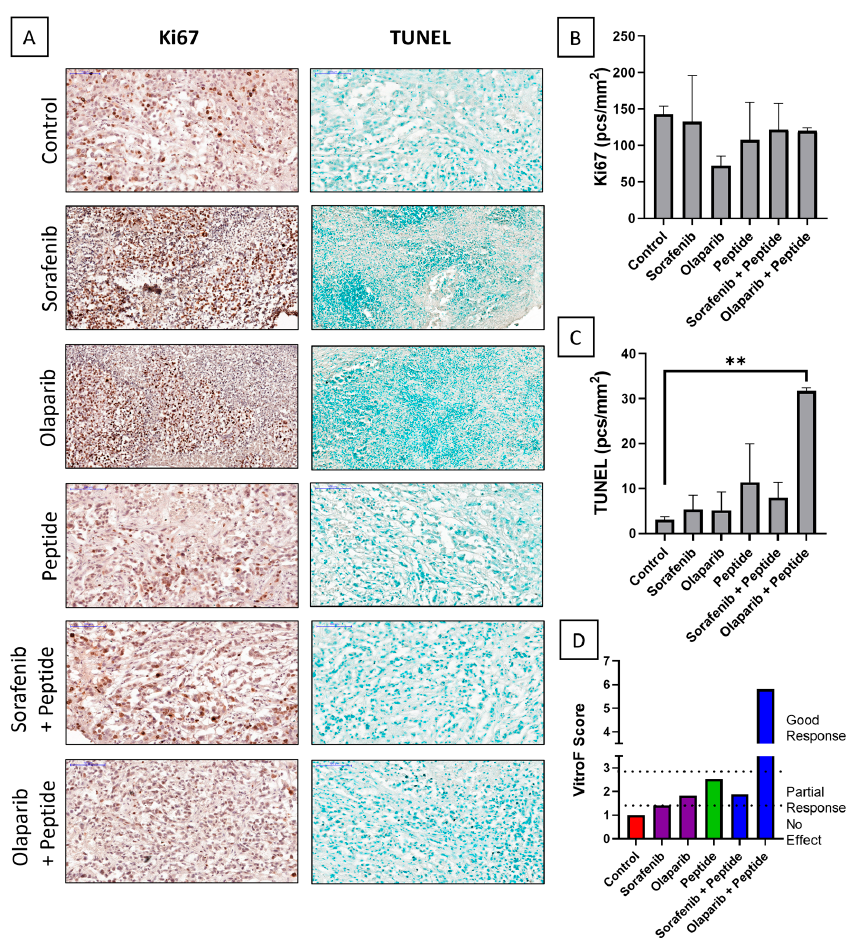
Figure 1. IHC staining of tissue explants of Patient #1 after ex vivo single and combinatorial drug treatment with olaparib, sorafenib and R11-NLS-Pep8. ( A ) Representative IHC images of control and treated explants showing cell proliferation marker, Ki67 and TUNEL assay (20 × magnification, 100 µ m scale-bar). Quantification of ( B ) Ki67 and ( C ) TUNEL positive cells of control and treated explants, expressed as object frequency (pcs/mm 2 ). Graphs representing mean ± SEM. ** p < 0.01, with ordinary one-way ANOVA multiple comparisons test, is significantly different from Control. ( D ) VitroF score of the treatments.